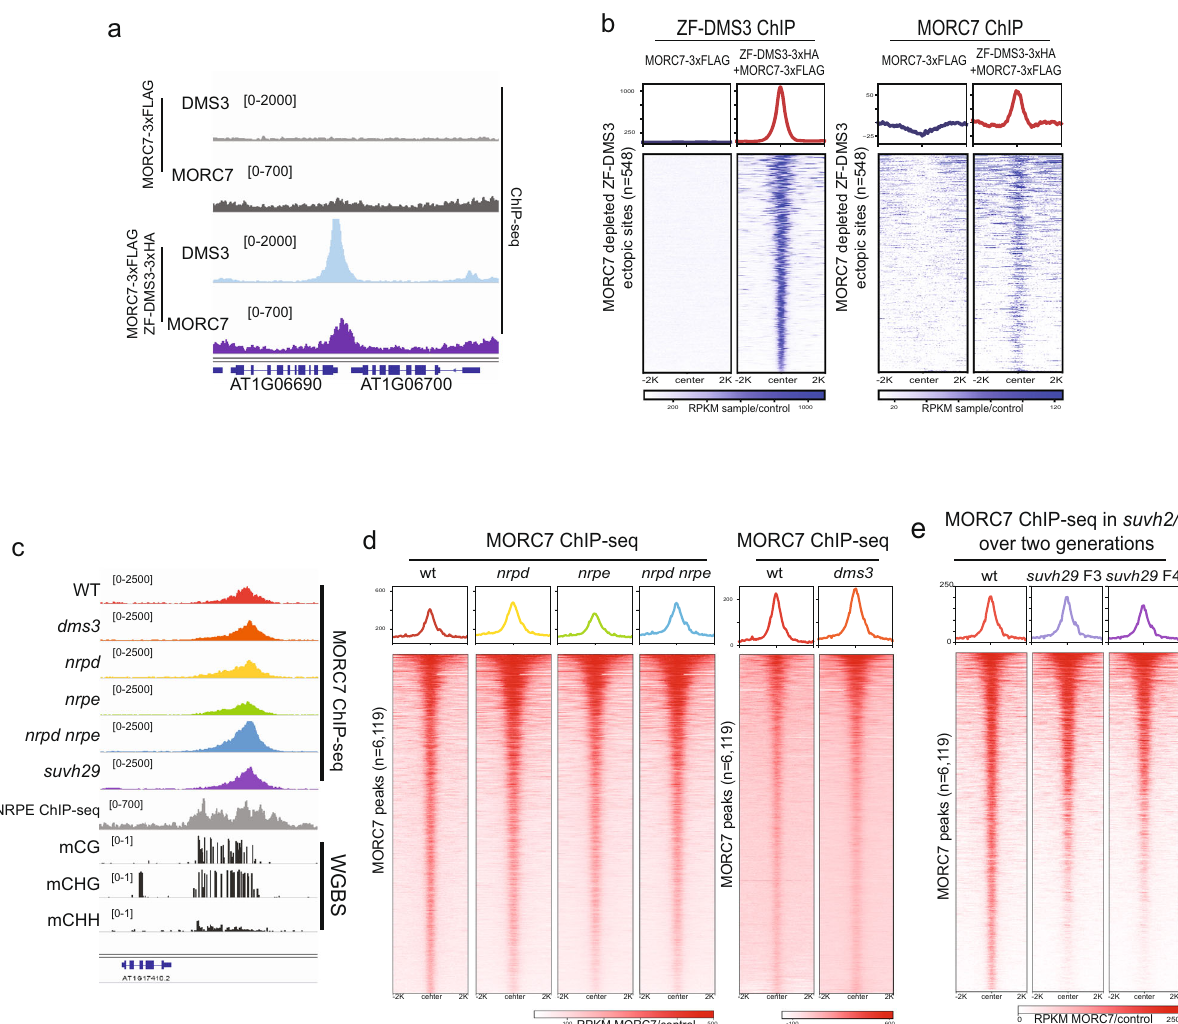
Fig. 2 MORC7 can be recruited by RdDM but its maintenance is independent of RdDM machinery. a Screenshot of a representative ectopic ZF-DMS3 locus displaying enrichment of MORC7 (RPKM sample/control). b Metaplot and heatmap showing enrichment of MORC7 ChIP-seq signals (right panels) over a subset of ZF-DMS3 ectopic sites (left panels (RPKM sample/control) ( n = 548). c Screenshot of MORC7 ChIP-seq (RPKM sample/control) in RdDM mutants (top six tracks), NRPE ChIP-seq (gray track), and methylation level (bottom three tracks) at a representative locus. d Metaplot and heatmap showing MORC7 ChIP-seq (RPKM sample/control) in RdDM mutants ( n = 6119). e Metaplot and heatmap showing MORC7 ChIP-seq (RPKM sample/control) in suvh2/9 over two generations ( n